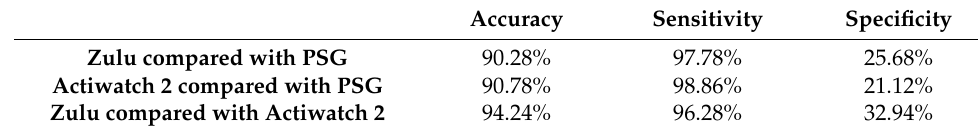
Table 1. Accuracy, sensitivity, and specificity for sleep–wake determination.